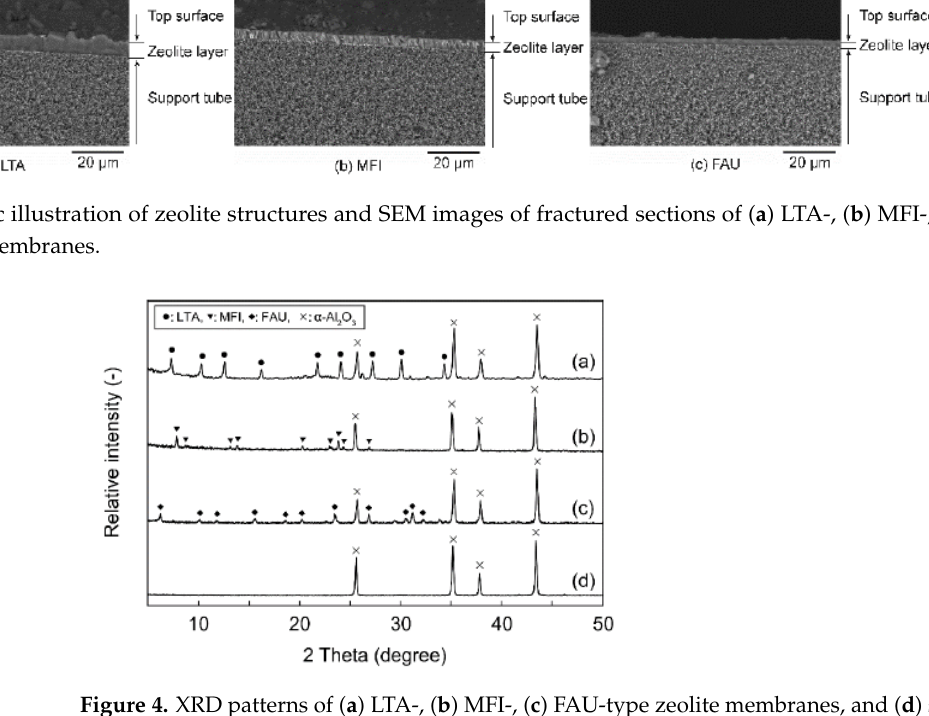
Figure 4. XRD patterns of ( a ) LTA-, ( b ) MFI-, ( c ) FAU-type zeolite membranes, and ( d ) support